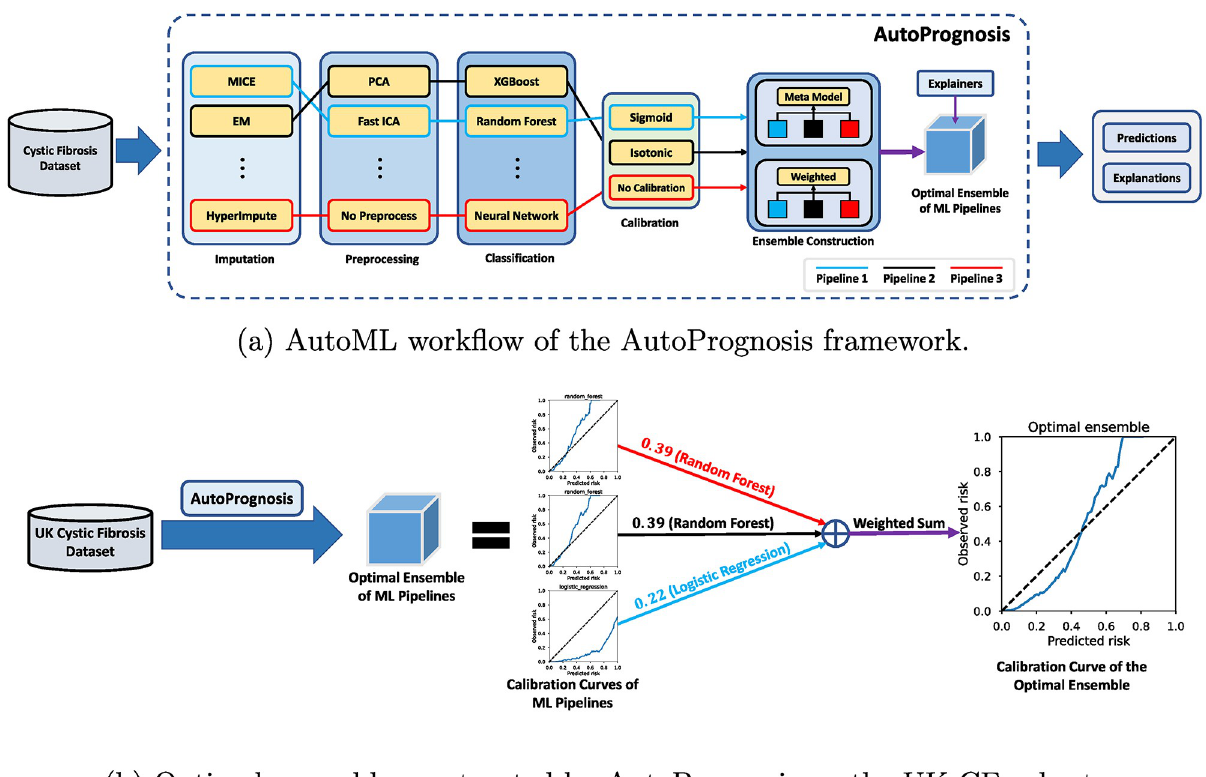
Fig 1. An overview of the AutoPrognosis framework. AutoPrognosis is a highly extensible AutoML framework built upon a plugin system. Based on the configured plugins for data imputation, preprocessing and classification, AutoPrognosis constructs an ML pipeline ensemble from the most performant pipelines developed with base classification plugins. (a) An example ensemble composed of three ML pipelines was illustrated to demonstrate the AutoML workflow of AutoPrognosis. All pipelines include four major procedures: imputation, preprocessing, classification, and calibration. In pipeline 1, the multivariate imputation by chained equations (MICE) plugin is applied for missing data imputation. The imputed data are then passed to fast ICA to create a compact, low-dimension data representation. The random forest classifier is used for the prediction task and its outputs are calibrated with a sigmoid function. Pipeline 2 and 3 are constructed in the same manner for the end-to-end prediction. AutoPrognosis first searches for the most performant ML pipelines among all possible combination of configured plugins. The selected pipelines are then combined as an ensemble model to achieve the best prediction performance. Two types of ensemble structure, i.e., stacked and weighted ensembles, are considered in AutoPrognosis, and Bayesian optimization is used to tune ensemble parameters for each structure. The optimal ensemble is selected based on the configured performance metric. Various explainer plugins of AutoPrognosis can be enabled for the ensemble to provide explanations along with the classification outputs. Detailed description of the algorithm can be found in [10–12]. (b) In this study, the UK CF dataset was provided as input to AutoPrognosis to search the optimal ML model for the composite endpoint prognostic task. The constructed ML model was a weighted ensemble of three ML pipelines. As illustrated in the calibration curves, the random forest pipelines tended to underestimate (above the dashed line) the risk level of high-risk patients. While the logistic regression pipeline was able to identify high-risk CF patients, its prognostic output was significantly higher than observed risks and would lead to many false alarms. AutoPrognosis was able to take advantage of all ML pipelines and create an optimal ensemble with the best prognostic